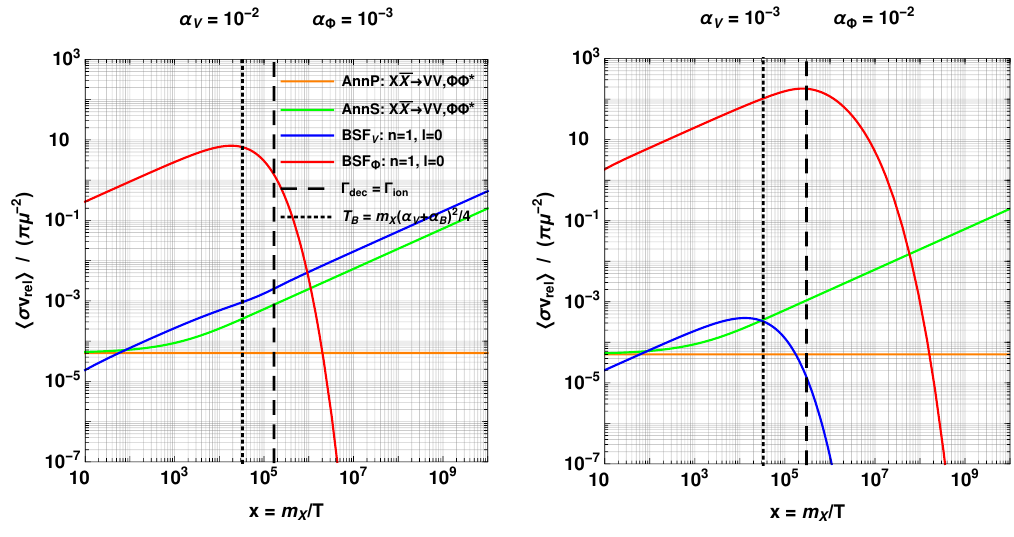
Figure 12 . The thermally averaged BSF and annihilation velocity-weighted cross-sections that we consider in the computation of the DM freeze-out, vs. x (cid:17) m =T . All cross-sections have X been normalised to (cid:25)=(cid:22) 2 , with (cid:22) = m = 2 being the reduced mass of the interacting particles. We X also mark two important mileposts: (i) the time when the temperature equals the binding energy T B = m ( (cid:11) + (cid:11) ) 2 = 4, at and below which the equilibrium occupation number of the bound states X V (cid:8) becomes very signi(cid:12)cant, and (ii) the end of ionisation equilibrium, below which the DM depletion rate saturates to the BSF rate and thus becomes sensitive to the BSF cross-section.